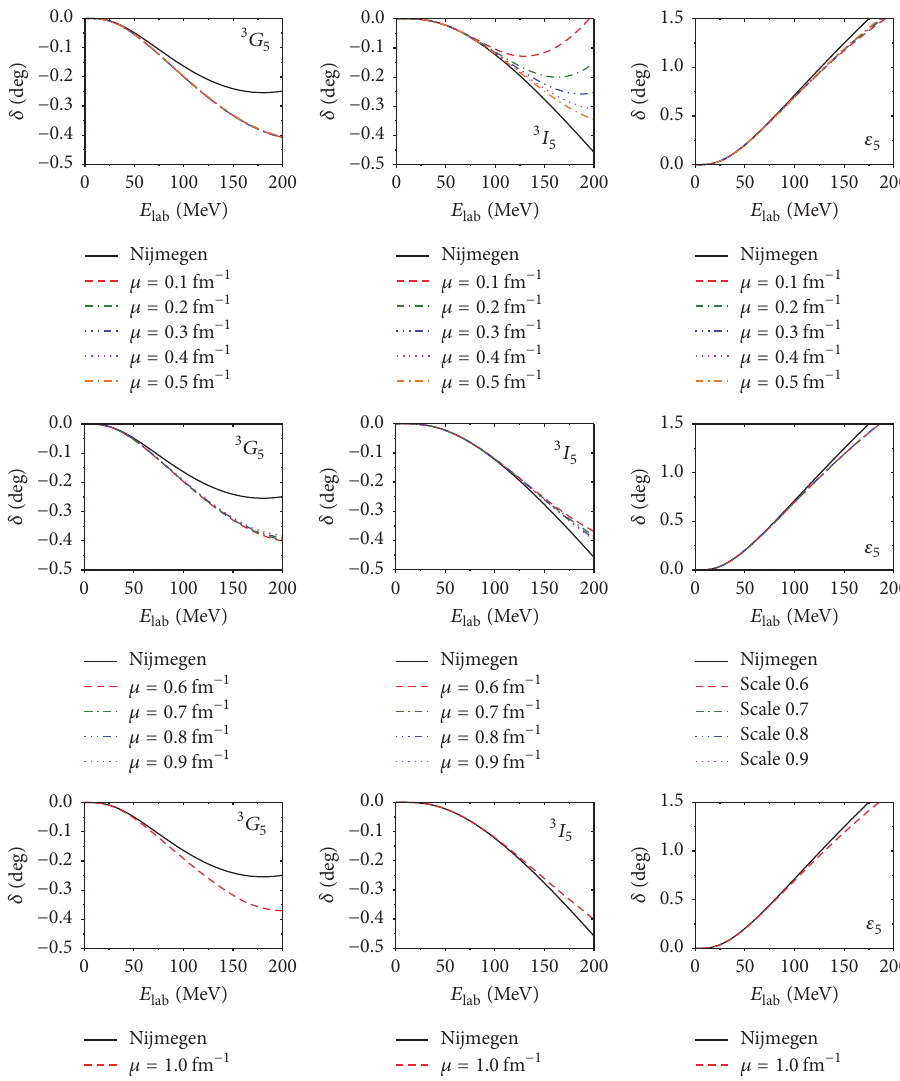
Figure 12: (Color on-line) phase shifts in 3 𝐺 5 − 3 𝐼 5 coupled channels calculated from the solution of the subtracted LS equation for the 𝐾 - matrix with five subtractions for the N3LO-EGM potential for several values of the renormalization scale compared to the Nijmegen partial wave